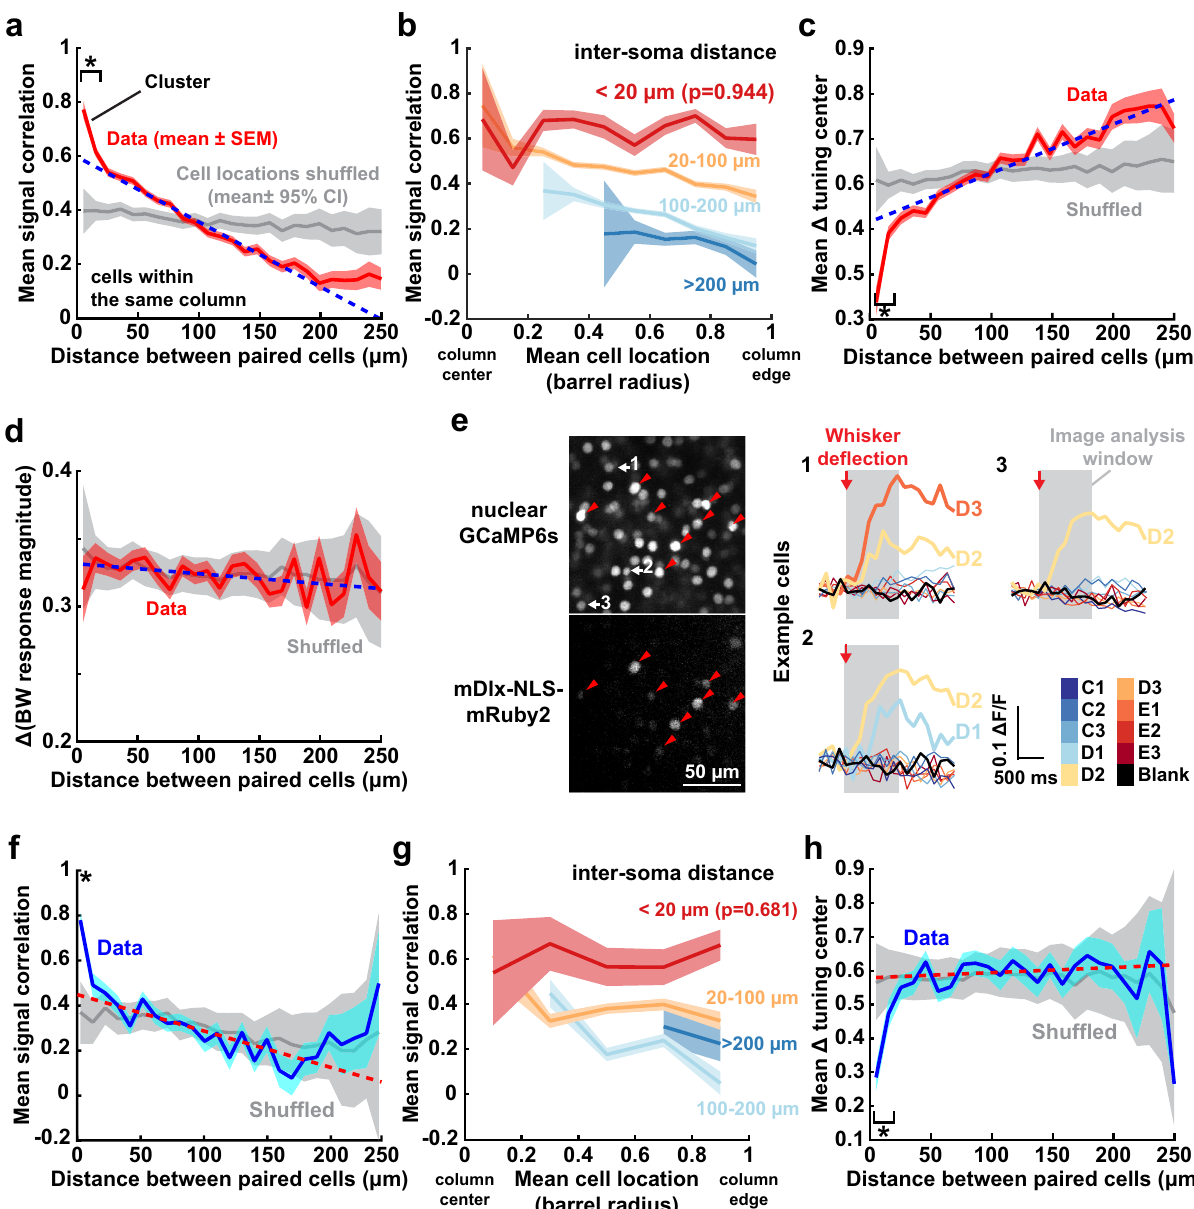
Fig.3|Existenceoflocaltuningclusterswithinawhiskercolumn.a Meansignal correlation between pairs of co-columnar neurons as a function of distance between neurons (10 µ m bins). Red: measured data. Gray: spatially shuf fl ed neu- rons. Dashed line: linear regression of measured data from 30 to 200 µ m. p -value